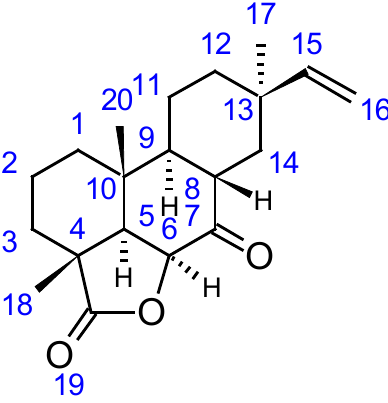
Figure 2. Chemical structure of compound 10 .